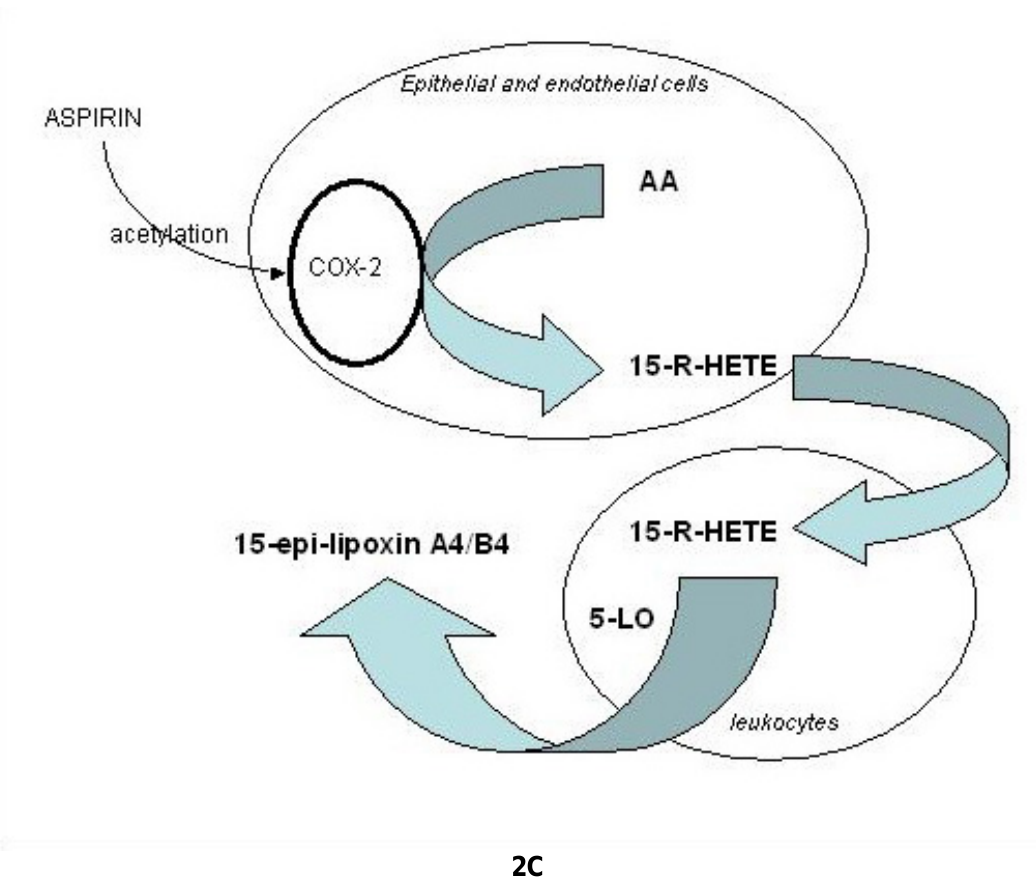
FIGURE 2. Arachidonic acid metabolism by LOX and COX family of enzymes. (A) The first pathway consists of the insertion of molecular oxygen into carbon 15 of arachidonic acid via 15-lipoxygenase. The intermediate 15S-H(p)ETE serves as an immediate substrate for the 5- lipoxygenase present in PMNs and monocytes inducing the formation of epoxide intermediate 5S, 6S, 15S epoxytetraene, further metabolized by hydrolases (lipoxin A4 and B4 hydrolases) to forming native lipoxin A 4 and lipoxin B 4 . (B) This second route consists in 5-lipoxygenase mediated synthesis of LTA4 in monocytes and epithelial cells. LTA4 is released and further metabolized by platelet 12-lipoxygenase or epithelial cell 15-lipoxygenase to the epoxide intermediate5S, 6S, 15S epoxytetraene further hydrolised by hydrolases A 4 and B 4 . (C) The remaining arachidonic acid initiated pathway leading to lipoxin biosynthesis is dependent on aspirin-mediated acetylation of COX-2 which converts arachidonic acid to its 15R-HETE conformation, which when released from endothelial cells can be metabolized to 15-epi-lipoxin A4 and B4 by leukocyte